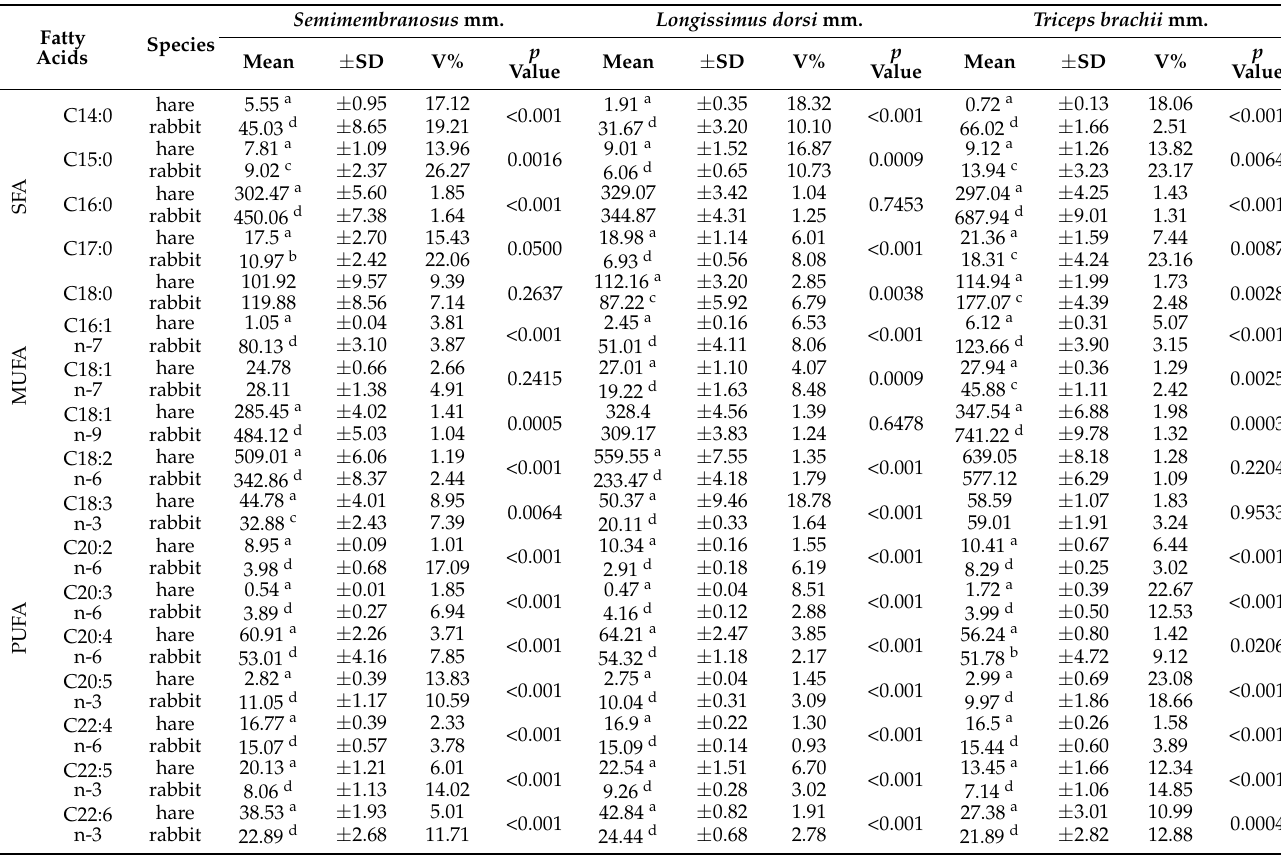
Table 3. Fatty acid content (mg/100 g) in hare and rabbit